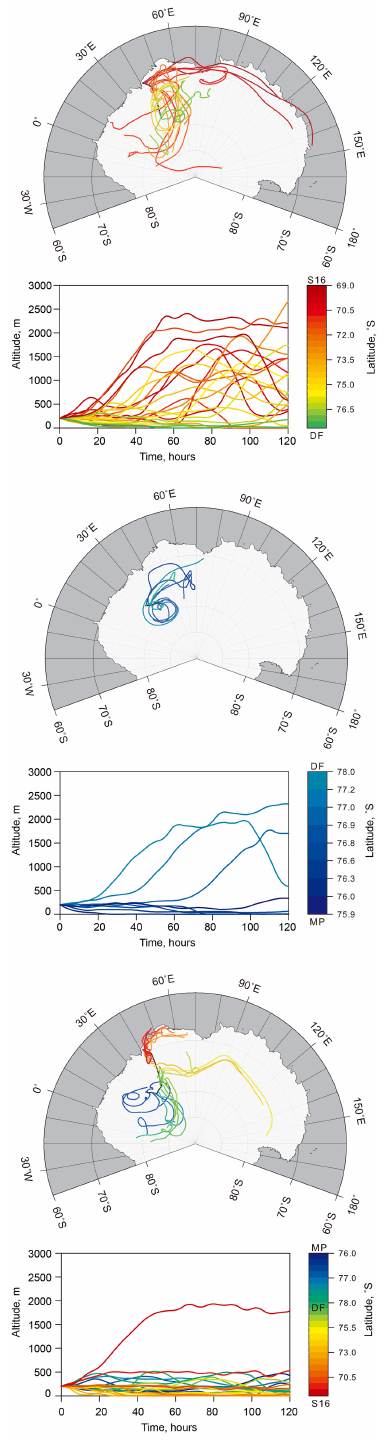
Figure 3. 5-day backward trajectories from every camp site in (a) incoming traverse from S16 to Dome F, and (b) traverse from Dome F (DF) to meeting point (MP), (c) traverse from meeting point to S16 in outgoing traverse. Black lines show the traverse route. Alti- tudes denote the height above the ground. Colour code corresponds to the latitude at starting points of the